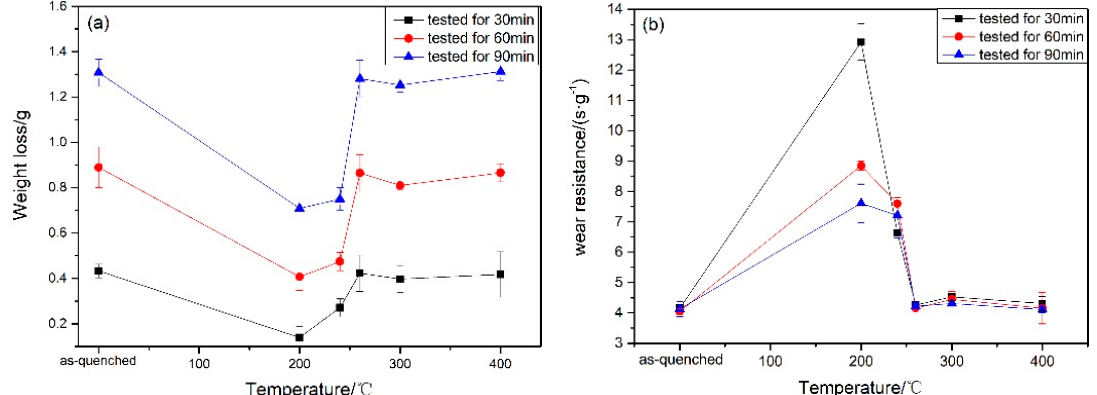
Figure 6. Wear resistance of the test steels tempered at different temperatures: ( a ) weight loss; ( b ) wear resistance.